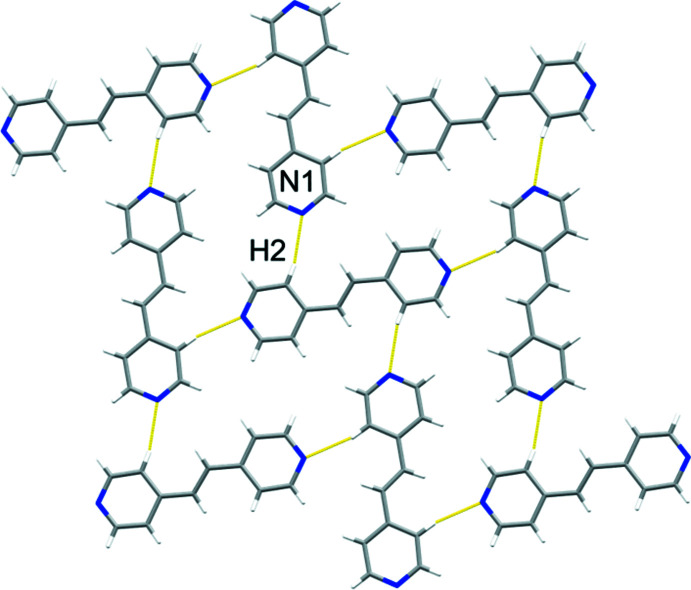
Planar, two-dimensional sheets of 4,4′-bpe.